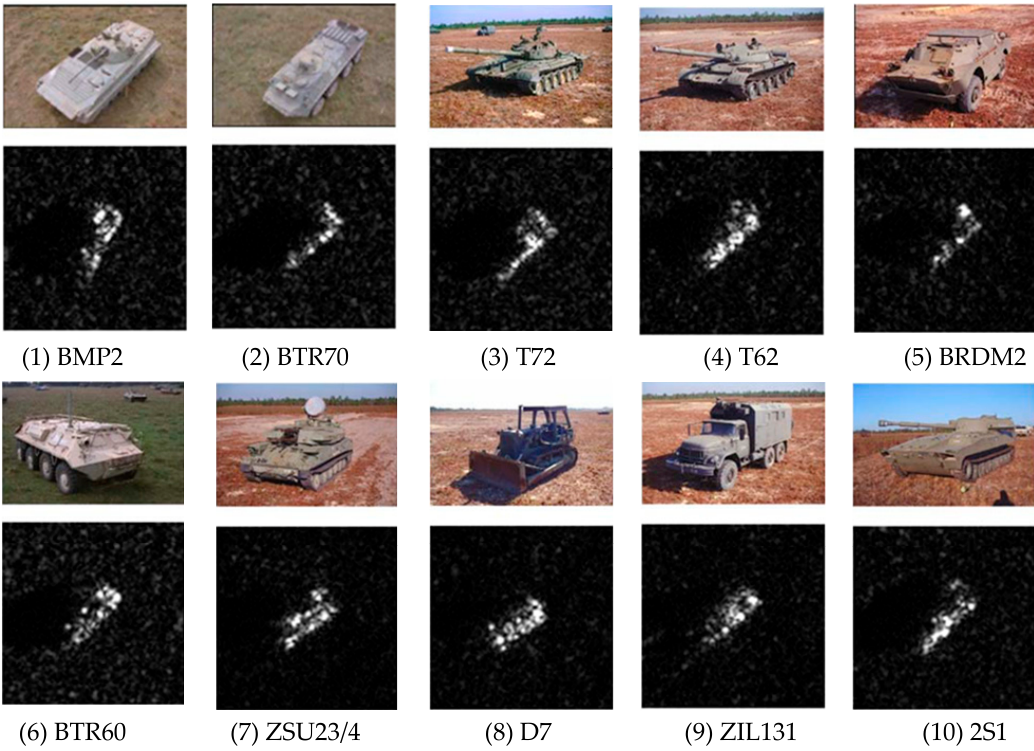
Figure 6. Types of military targets: ( top ) optical images; and ( bottom ) SAR images. Table 2. Training and test sets in the experiments.